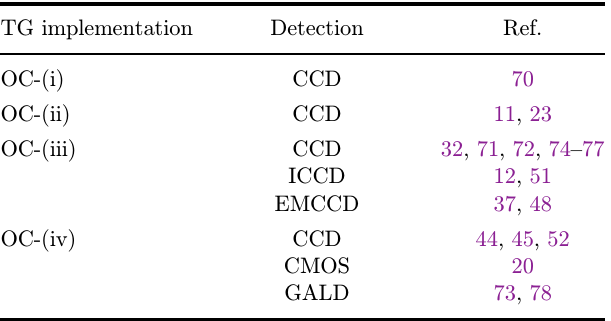
Table 3. Summary of TG implementation based on optical choppers. TG implementation